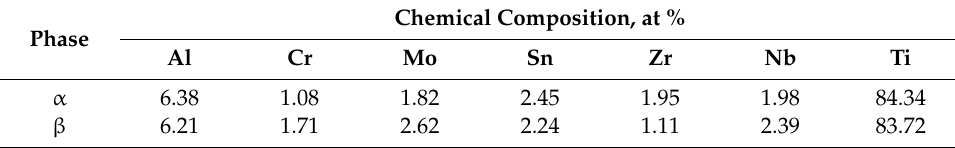
Table 5. Chemical composition (at %) of different phases in TC21 alloy.